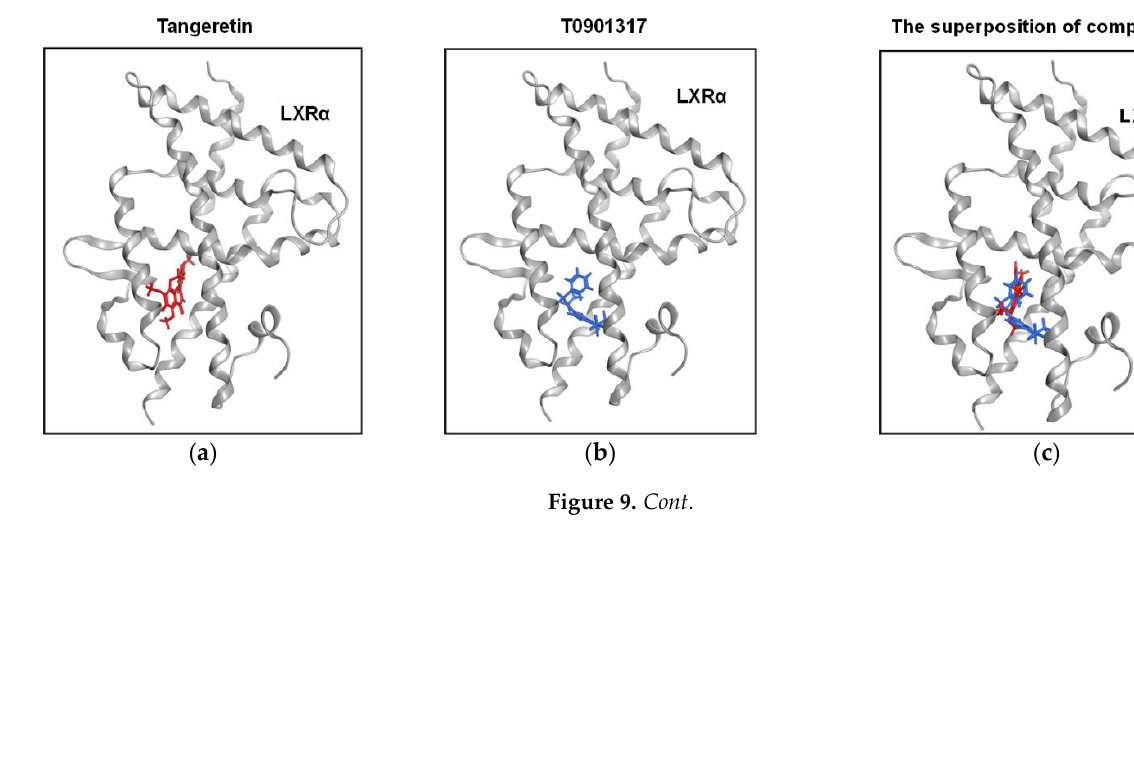
( e ) Figure 9. Tangeretin can dock into the ligand-binding domain of LXRα. The poses of tangeretin and T0901317 docked preferentially to the ligand-binding domain of LXRα. LXRα is shown as a gray ribbon, and the compounds are shown in ( a ) red (tangeretin) and ( b ) blue (T0901317). ( c ) The superposition of both tangeretin and T0901317 docked to the ligand- binding pocket of LXRα. Two-dimensional interaction map of LXRα with ( d ) tangeretin and ( e ) T0901317. The hydropho- bic and hydrophilic amino acid residues near the compounds are colored green and pink, respectively. 3. Discussion The lipid-lowering effects of citrus tangeretin on the regulation of dyslipidemia have been reported in numerous studies. To our knowledge, this is the first report to show that tangeretin inhibits the gene expression of hepatic ANGPTL3 via counteracting the activity of LXRα, a key regulator for lipid homeostasis. The decreases in intracellular and secreted ANGPTL3 proteins by tangeretin may augment LPL catalytic activity during the hydrol- ysis of TGs in lipoproteins, resulting in a reduction of TG accumulation in circulation (Fig- ure 10).